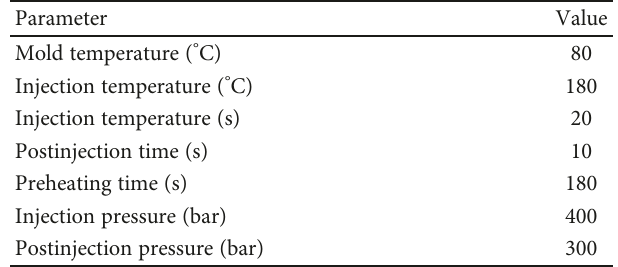
Table 3: Injection process parameters.